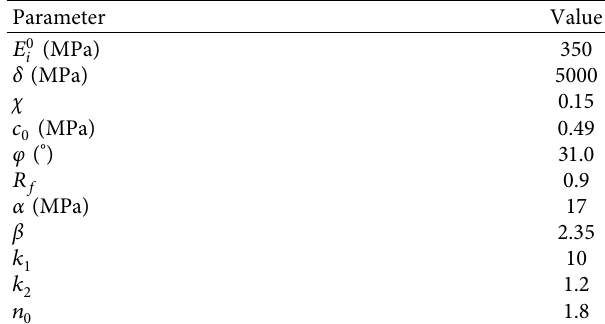
Table 4: Model parameters.